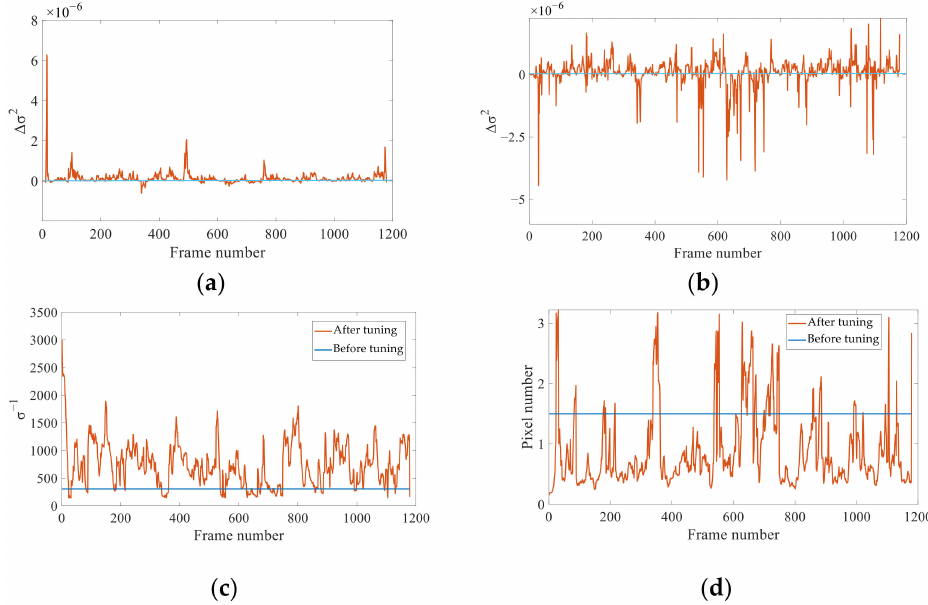
Figure 7. Changes in the relevant parameters after re-optimization. ( a ) Increase in unit-weight RMSE of the IMU measurements. ( b ) Increase in unit-weight RMSE of the visual reprojections. ( c ) Changes in the visual reprojection weights. ( d ) Manifestation of the visual reprojection weights on the image